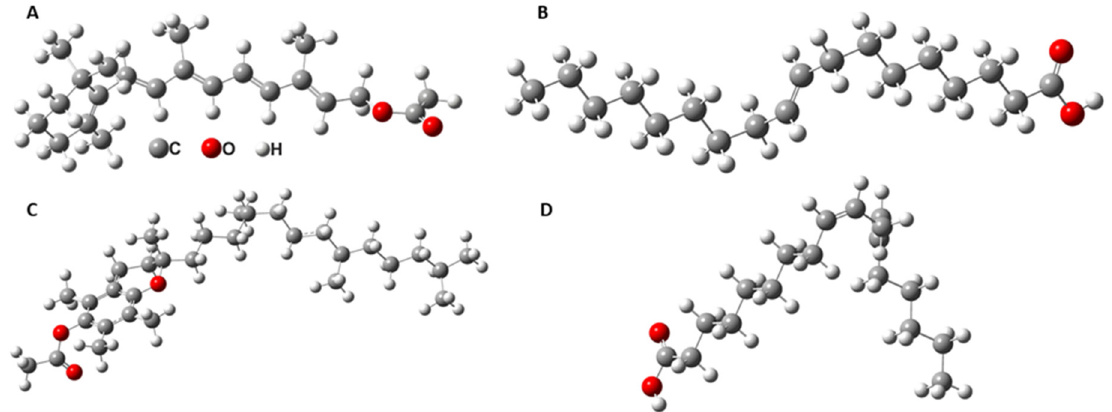
Figure 3. Major components of an optimized chemical structure of oily vitamin A: ( A ) vitamin A; ( B ) oleic acid; ( C ) linoleic acid; and ( D ) α -tocopherol acetate.